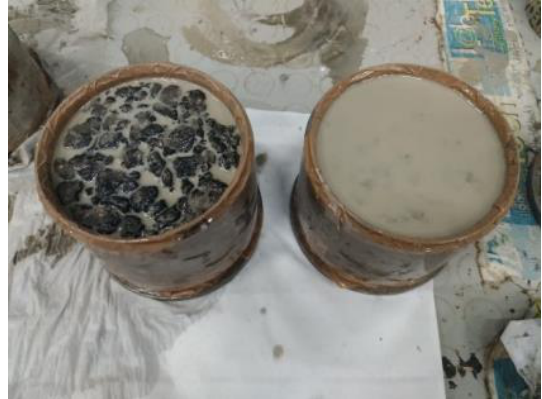
Figure 2. Grouted macadam sample-producing phase.